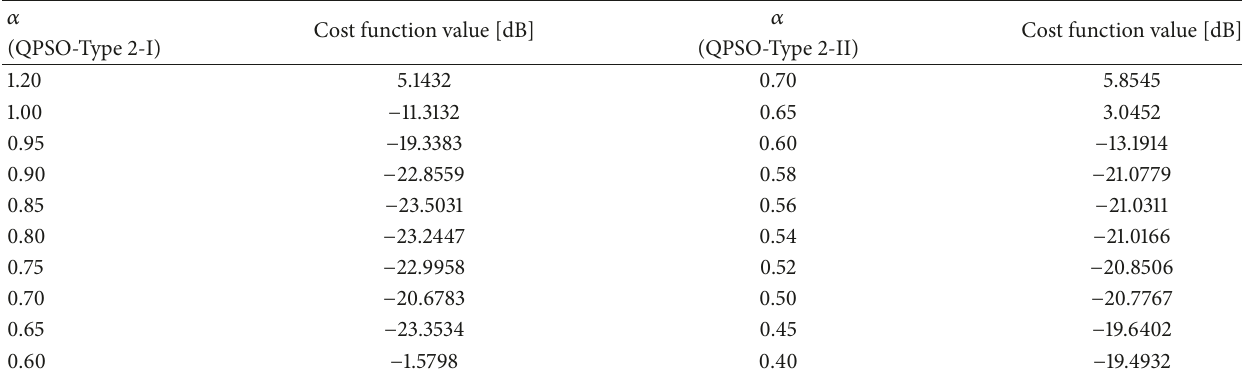
Table 2: Best cost function values obtained by